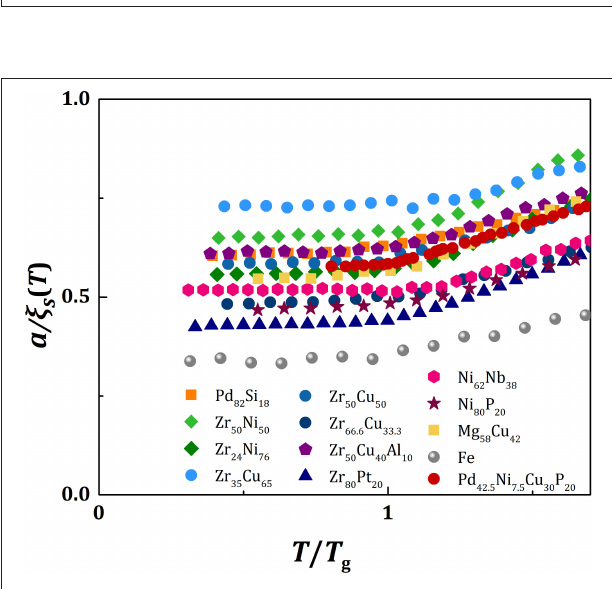
FIGURE 2 | The plots of a /ξ s ( T ) against T/T g for various metallic